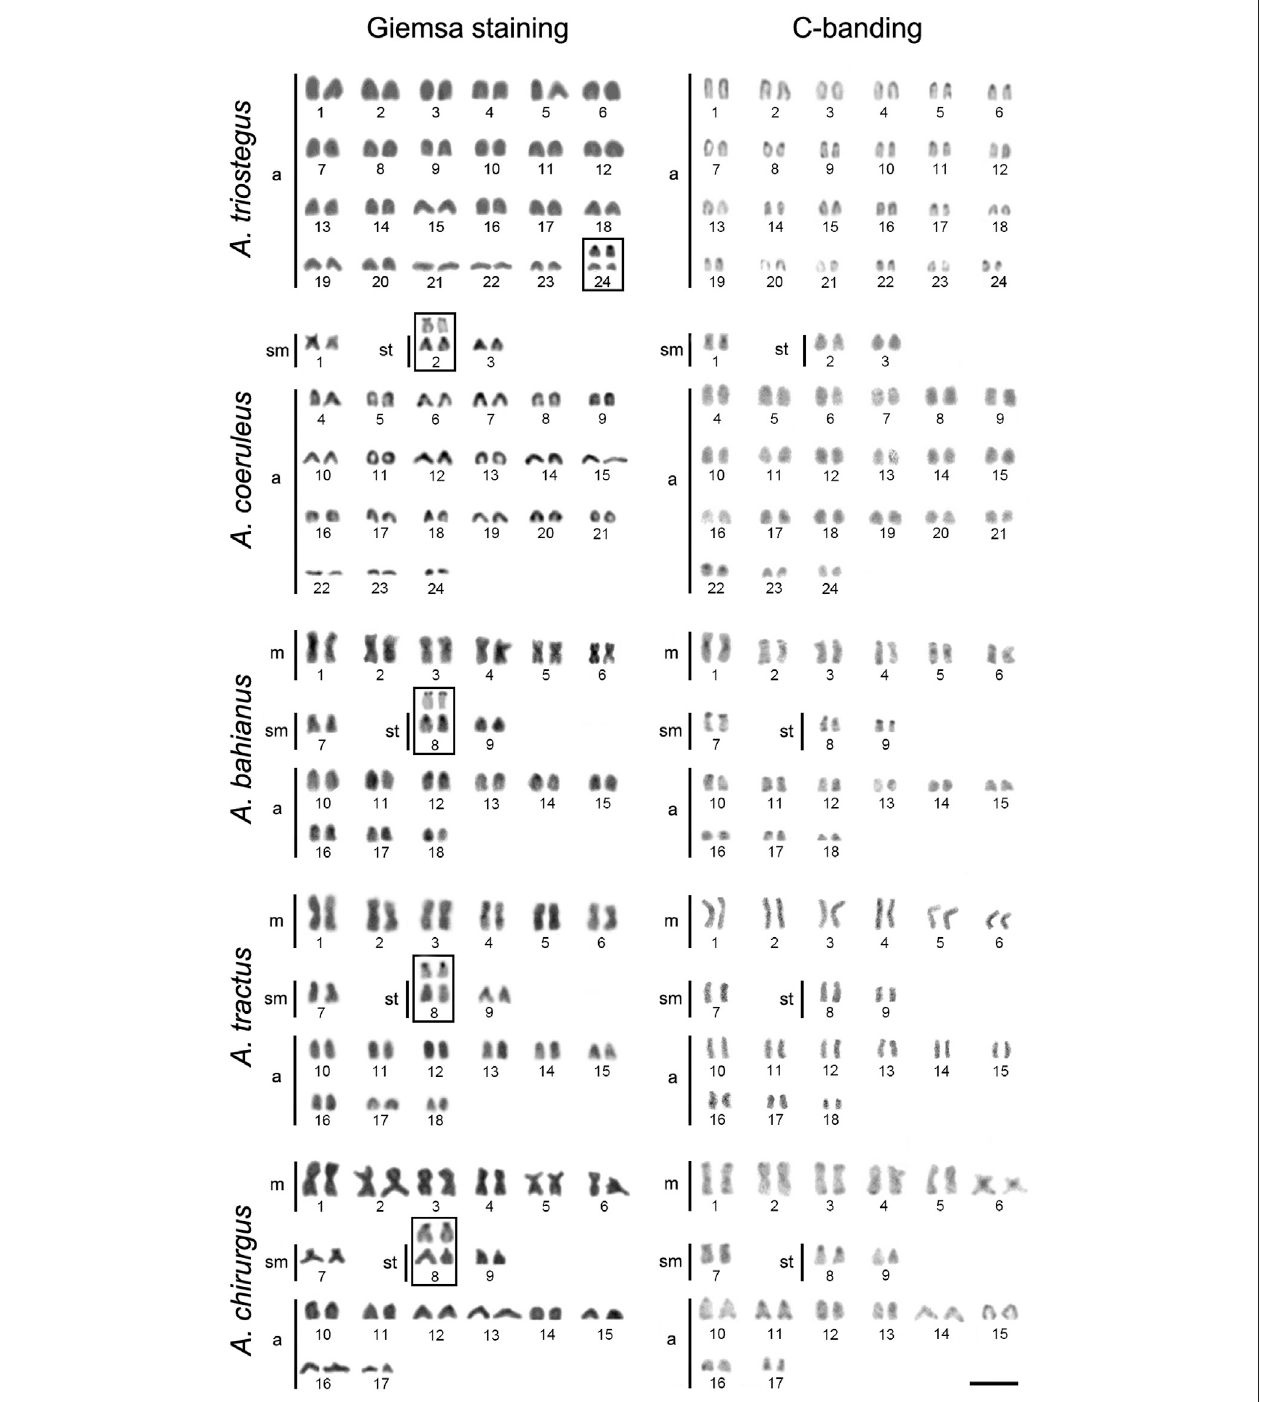
FIGURE 1 | Karyotypes of Acanthurus triostegus , Acanthurus coeruleus , Acanthurus tractus , Acanthurus bahianus , and Acanthurus chirurgus after Giemsa- staining and C-banding. Boxes highlight the chromosome pair with Ag-NORs (silver stained NORs). m – metacentric, sm – submetacentric, and a – acrocentric chromosomes. Scale bar (cid:2) 5 μ m.